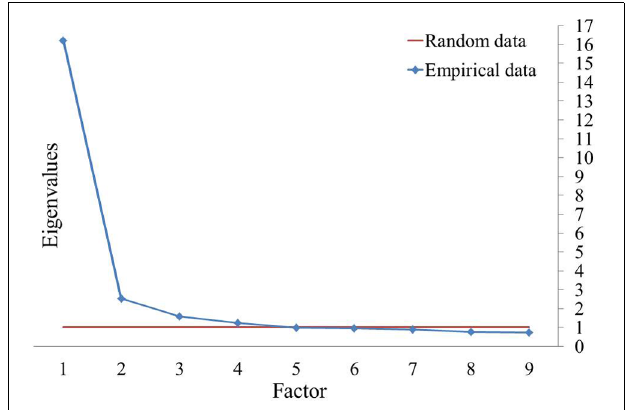
FIGURE 1 | Scree plot and parallel analysis of eigenvalues in